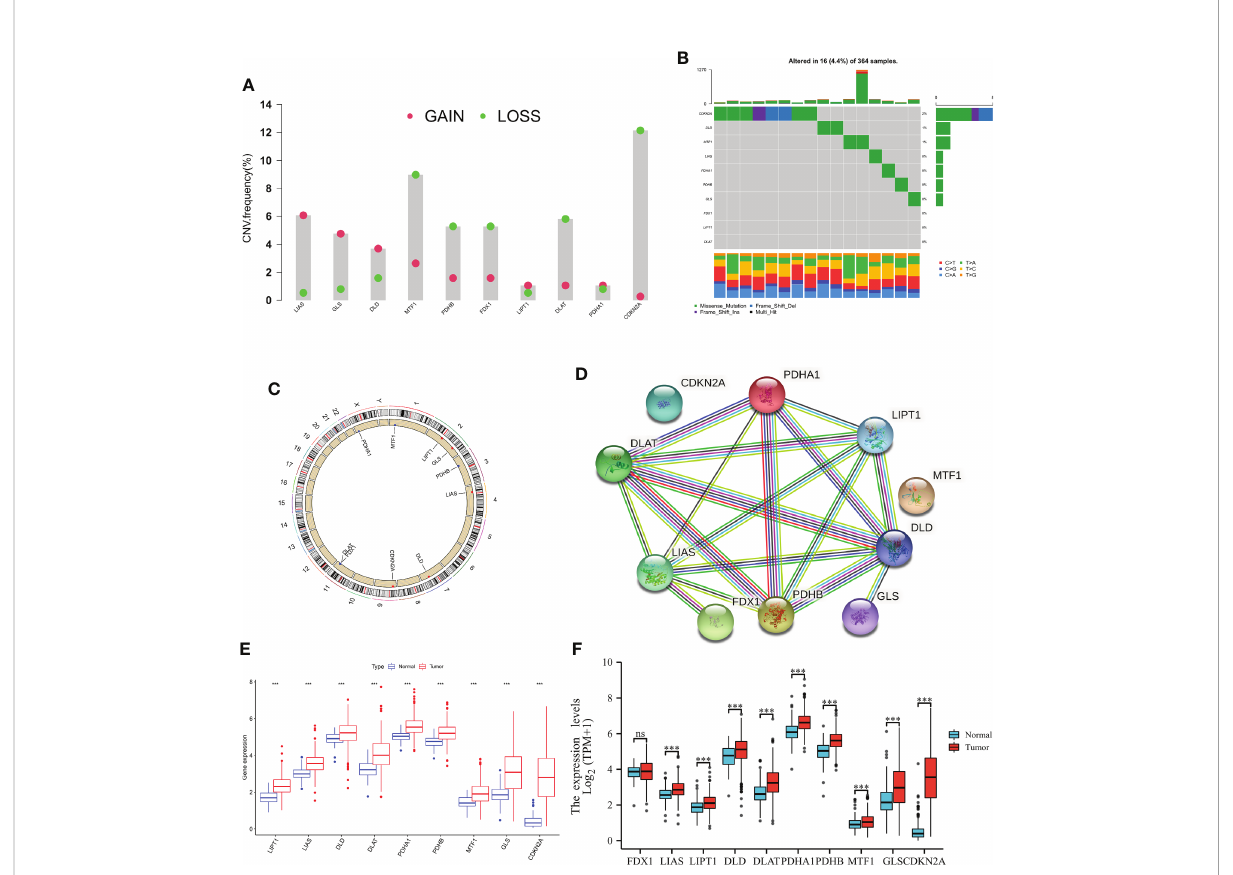
FIGURE 1 Genetic and transcriptional alterations of CRGs in HCC. (A) Frequencies of CNV gain, loss, and non-CNV among CRGs. (B) Mutation frequencies of 10 PRGs in 364 patients with HCC, respectively, from the TCGA cohort. (C) Locations of CNV alterations in PRGs on 23 chromosomes. (D) cuprotosis-related genes are mapped on proteins in the human protein-protein interaction network. (E, F) Expression distributions of 10 CRGs between normal and HCC tissues from the TCGA and UCSCXENA database, respectively. NS, Not statistically signi fi cant. *P < 0.05, **P < 0.01, ***P <